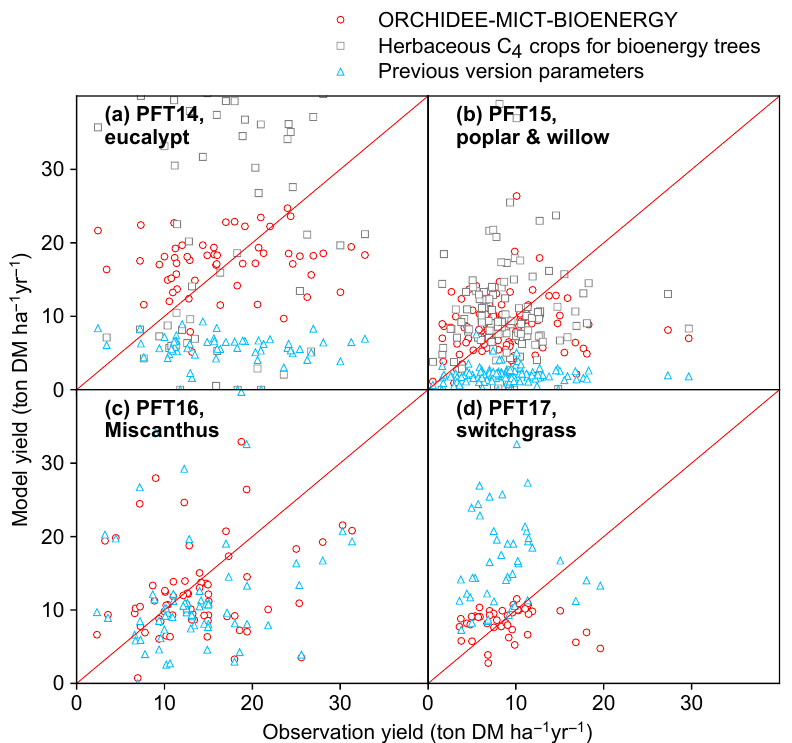
Figure 11. Comparison of biomass yields simulated by ORCHIDEE-MICT-BIOENERGY and previous versions. Only median values in half-degree grid cells, some containing multiple sites, are shown for both simulated and observed yields. Red circles represent the simula- tions using specific bioenergy parameterizations (same as Fig. 3). Gray squares represent using the herbaceous crop PFTs of the previous ORCHIDEE version for bioenergy trees, i.e., PFT13 for both PFT14 and PFT15 (Table 2). Blue triangles represent the simulations using the right PFTs but the parameters of the previous ORCHIDEE version, i.e., parameters of PFT2 (tropical broad-leaved evergreen), PFT6 (temperate broad-leaved summergreen), PFT13 (C 4 crop), and PFT13 (C 4 crop) for PFT14 (eucalypt), PFT15 (poplar and willow), PFT16 ( Miscanthus ), and PFT17 (switchgrass), respectively (Table